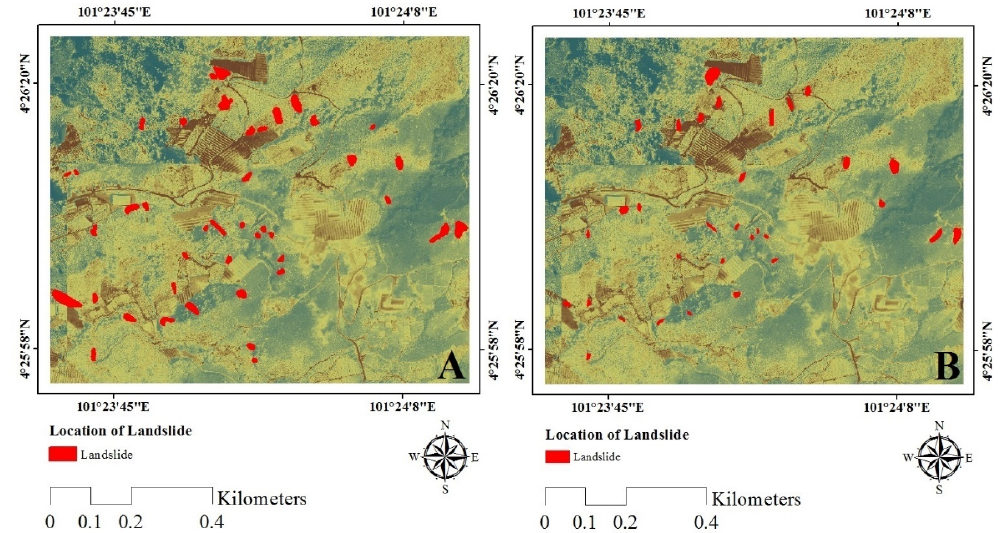
Figure 9. Results of the qualitative assessment of ( A ) RNN and ( B ) MLP ‐ NN for the analysis area.